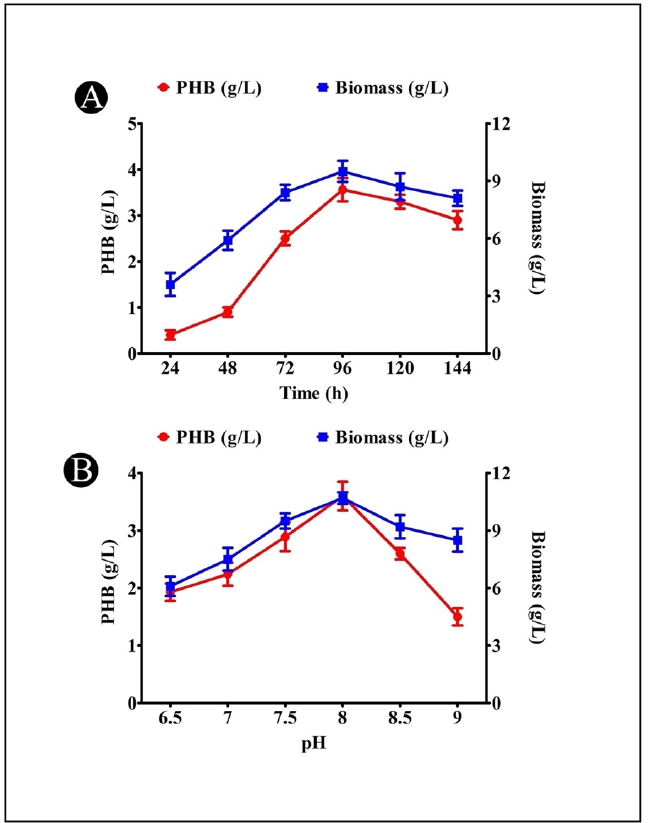
Figure 3. ( A ) Effect of incubation time on PHB production by A. indicus strain B2; ( B ) effect of pH on PHB production by A. indicus strain